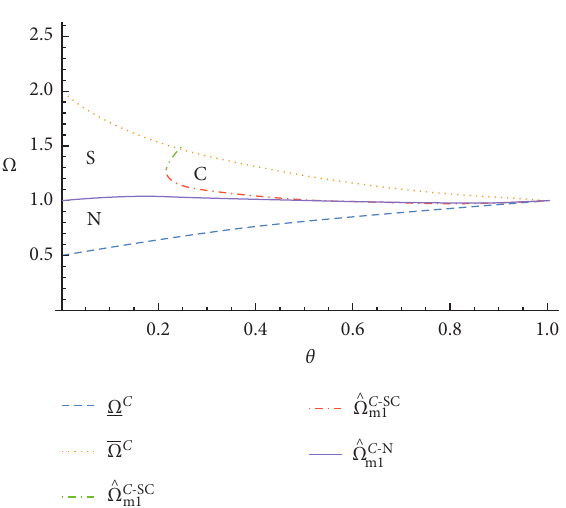
Figure 2: Cooperation mode choice for manufacture